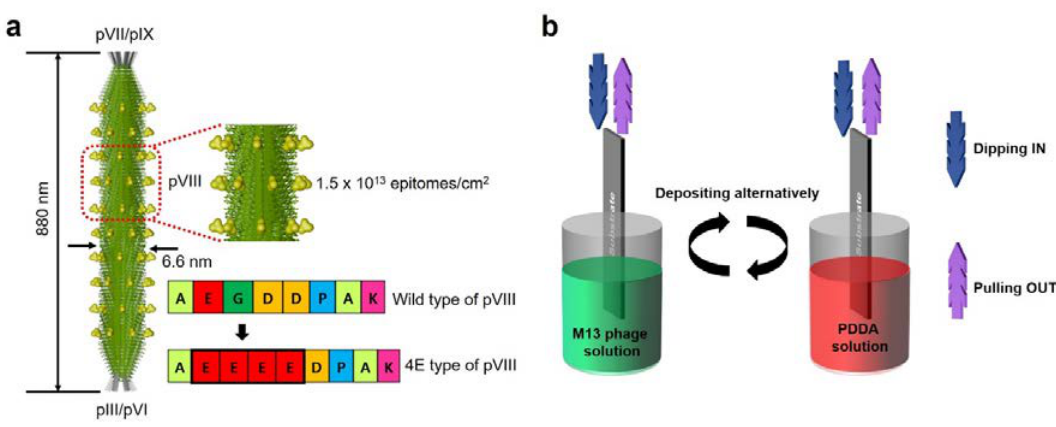
Figure 1. ( a ) Illustration of the structure of M13 phage and pVIII, pVII/pIX, and pIII/pVI amino acid sequences. pVIII genetic engineering site information shows conversion from wild type to 4E-type phage. ( b ) Schematic of the pulling method used to produce M13 phage/polydiallyldimethylammonium chloride (PDDA) multilayered films on